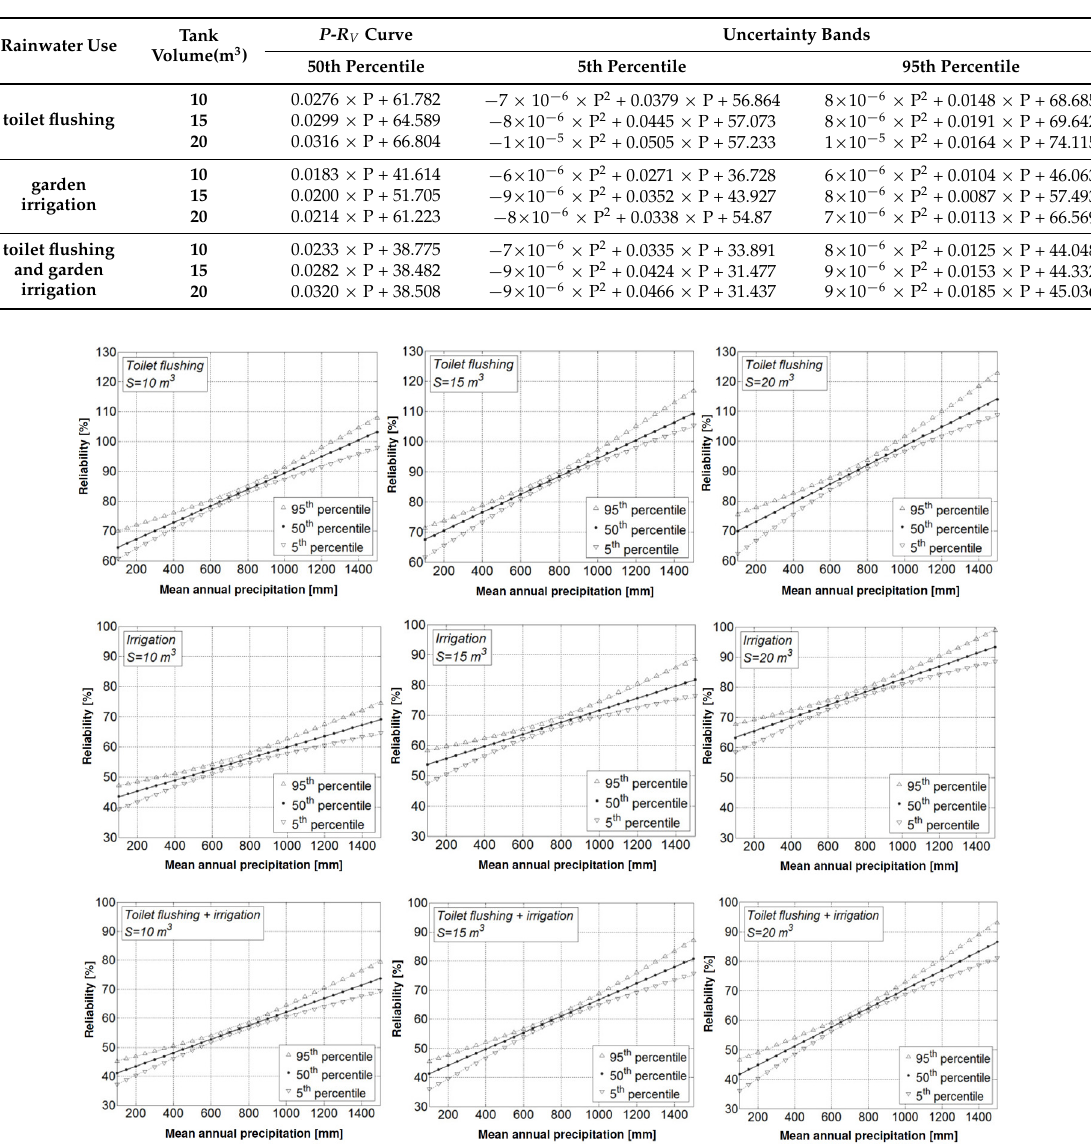
Table 3. Equations of interpolating curves of 5th, 50th and 95th percentiles for each rainwater use and tank volume.